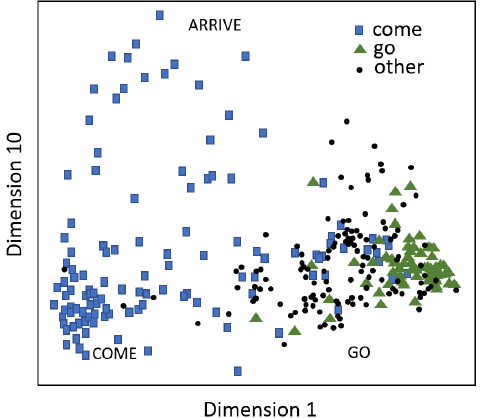
Figure 3. Impression of dimensions 1 and 10 from Wälchli and Cysouw (2012), with markup based on the English version of the gospel by Mark (see also Figure 3 in Wälchli and Cysouw (2012)).